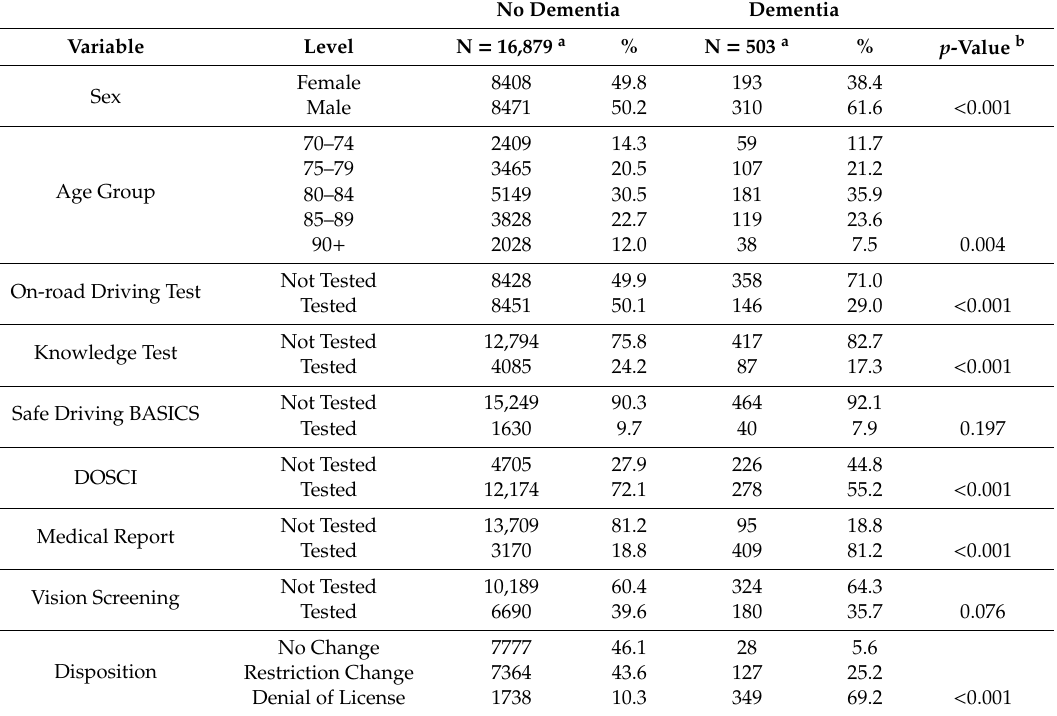
Table 2. Di ff erences in administration of the test to drivers with and without